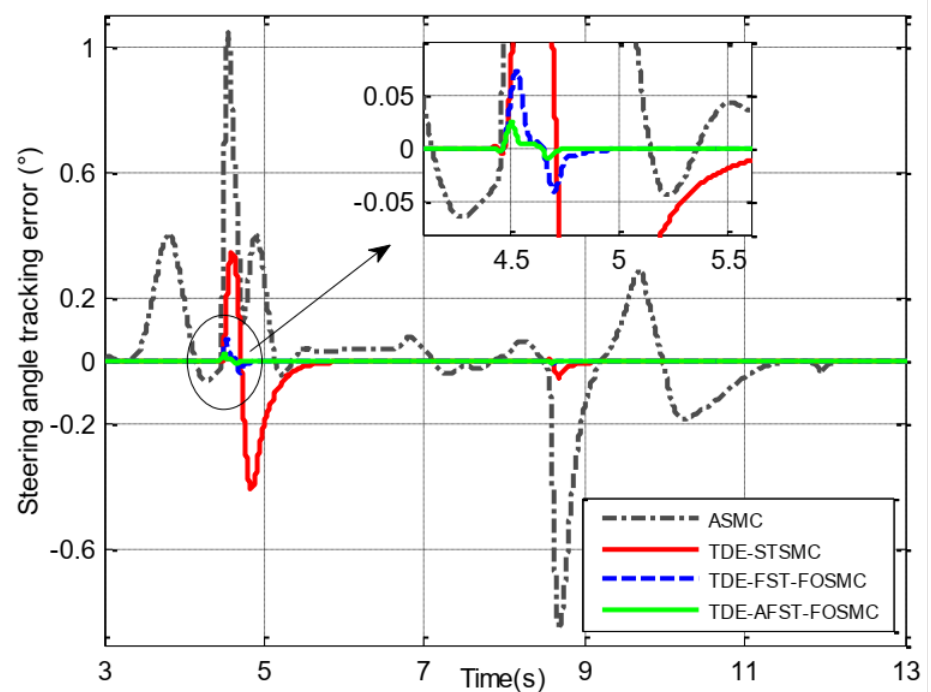
Figure 10. Tracking error of steering wheel